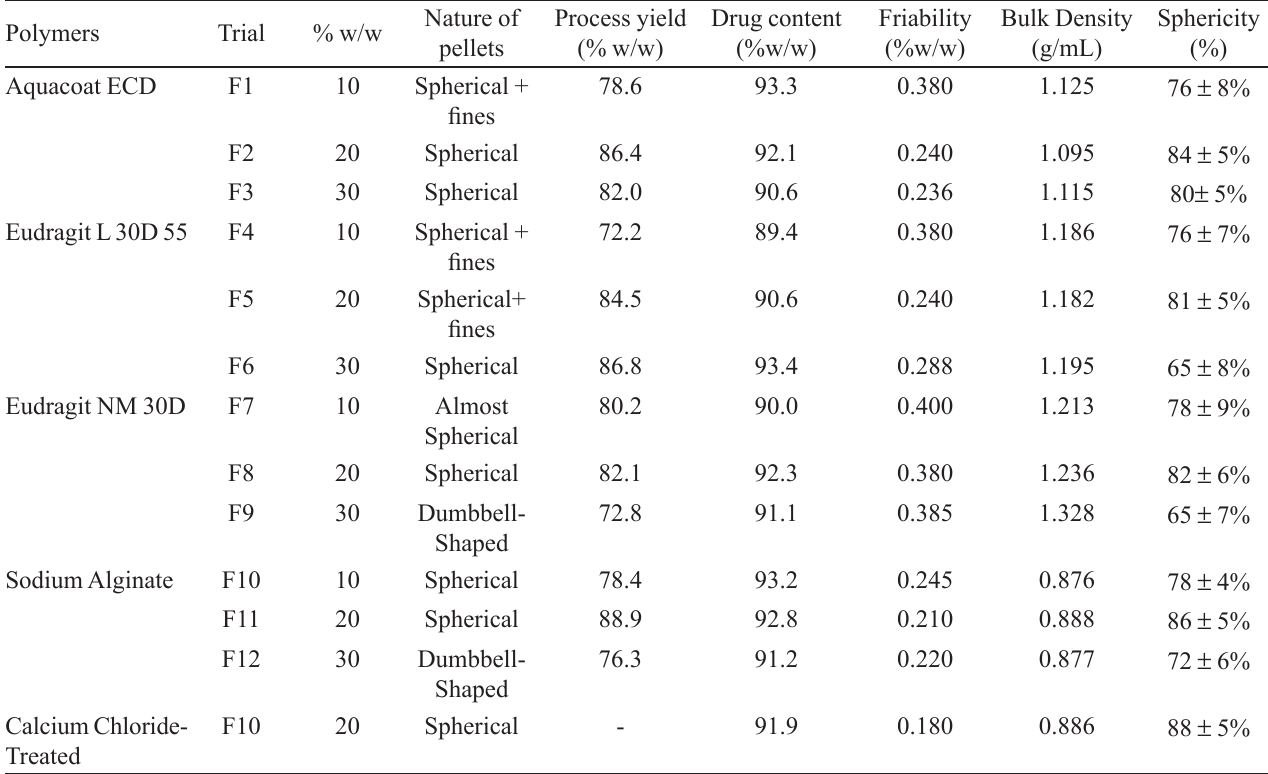
TABLE III - Physical characterization data of matrix pellets prepared using extrusion/spheronization process